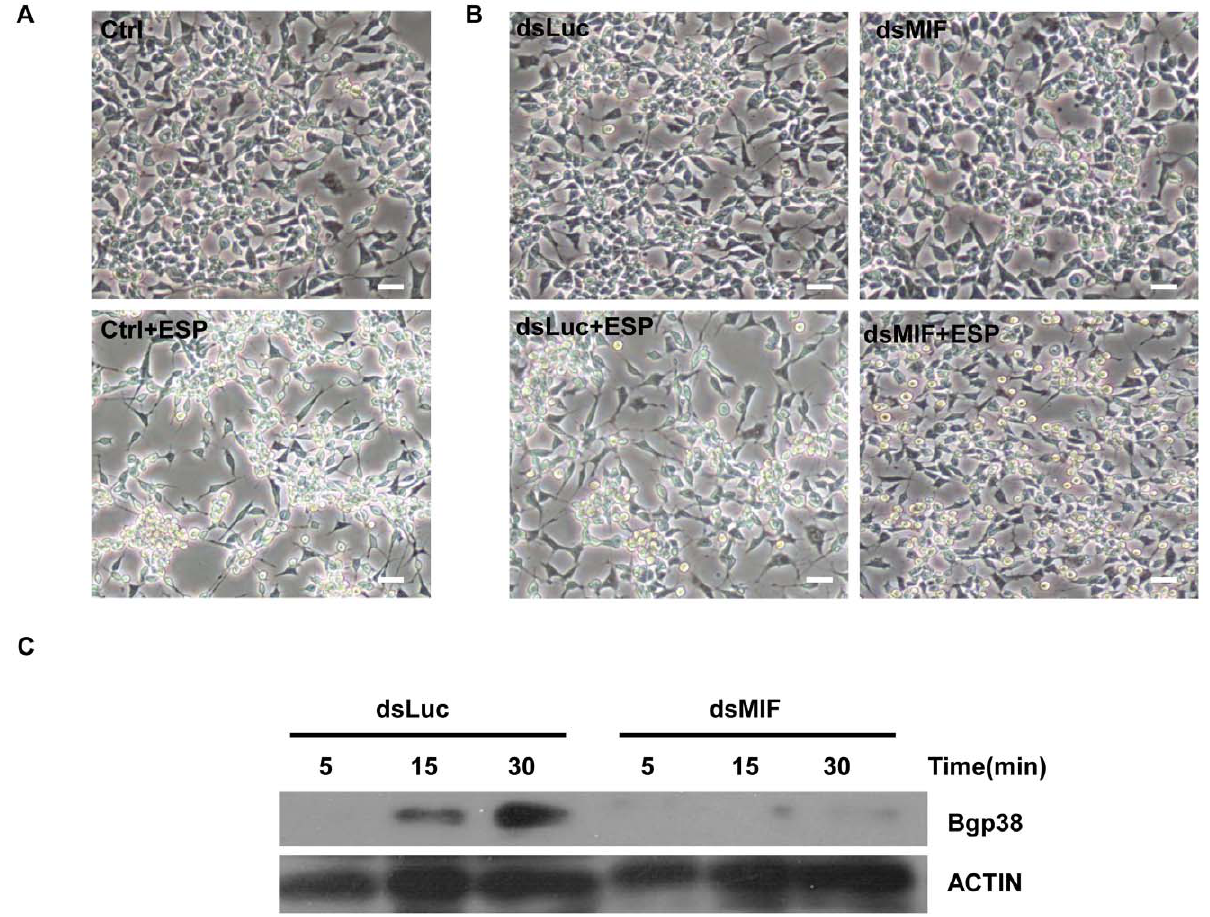
Figure 6. BgMIF promotes an aggregative phenotype and Bgp38 activation induced by ESP. (A) Effect of S. mansoni ESP (120 m g/mL) on the aggregative behavior of Bge cells. Cells incubated in the absence of ESP have a uniform distribution but cells incubated with ESP are clumped and their shape had changed. (B) Effect of S. mansoni ESP (120 m g/mL) on the aggregative behavior of Bge cells exposed to Luc (dsLuc) or BgMIF (dsMIF) dsRNA for 3 days and subsequently incubated or not with 120 m g/mL of sporocyst ESPs. Cells treated with dsLuc show normal aggregative behavior in the presence of ESP whereas those treated with dsMIF no longer aggregate in the presence of ESP. Note that the same number of Bge cells (2 6 10 5 ) was used in each case. Scale bar represents 100 m m. (C) Effect of S. mansoni ESP (120 m g/mL) on the activation (phosphorylation) of Bgp38 of dsRNA treated Bge cells.